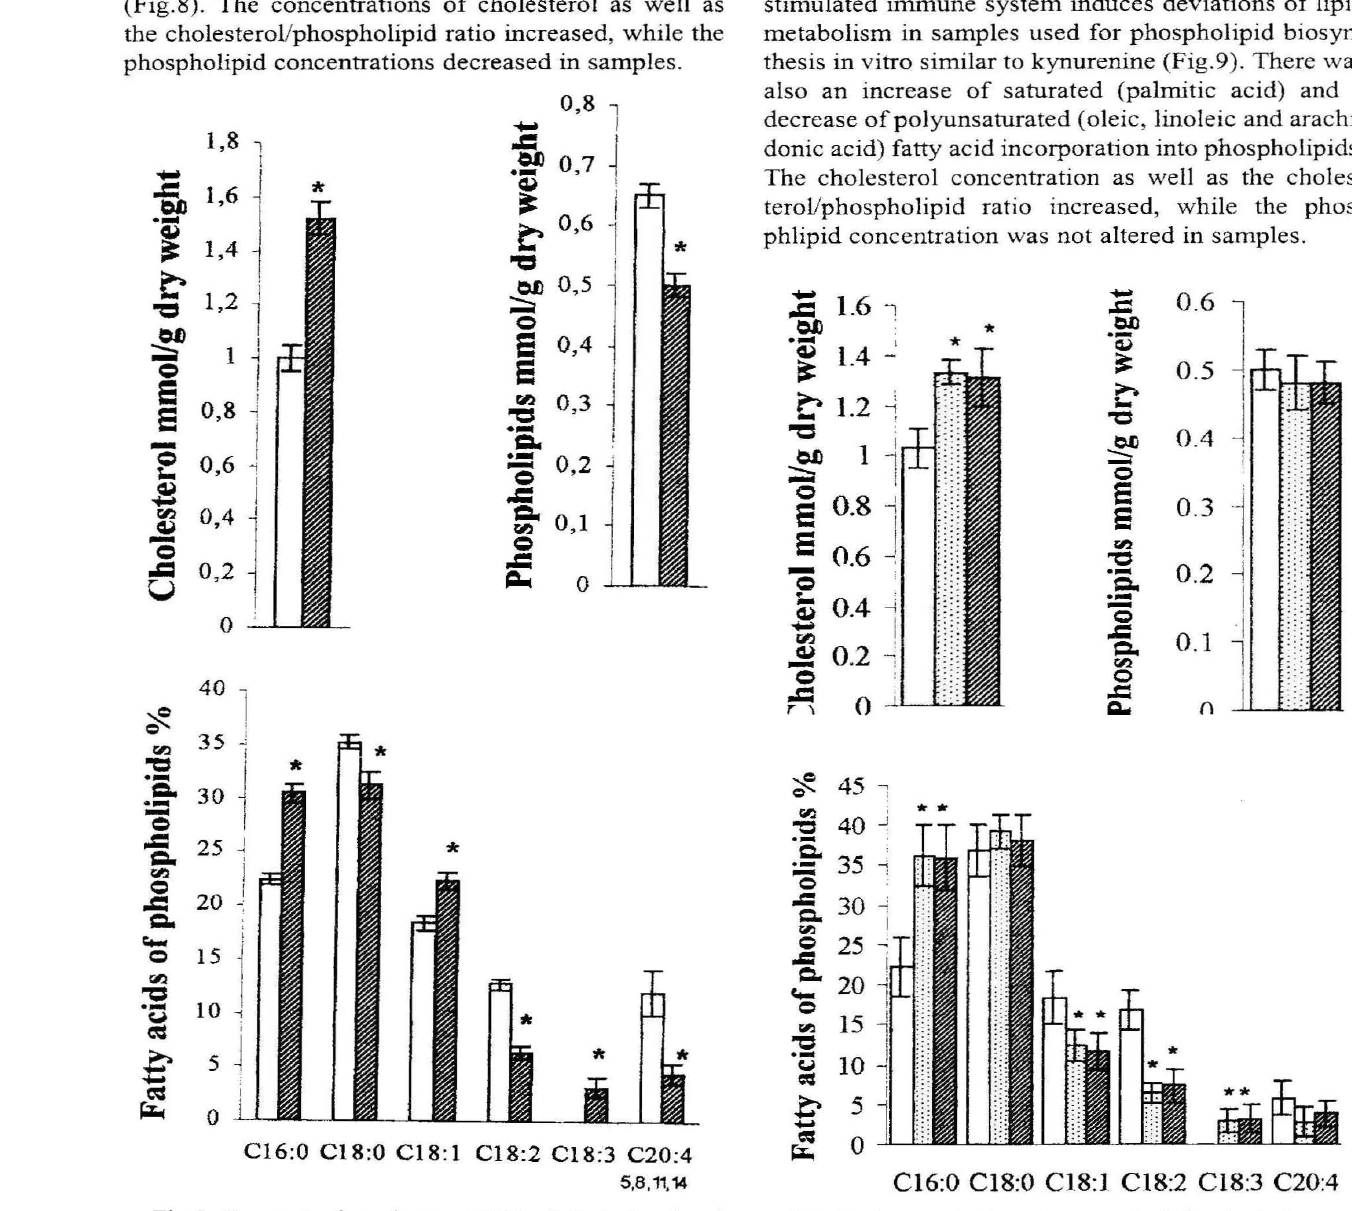
PteridineslVol. lllNo. 4